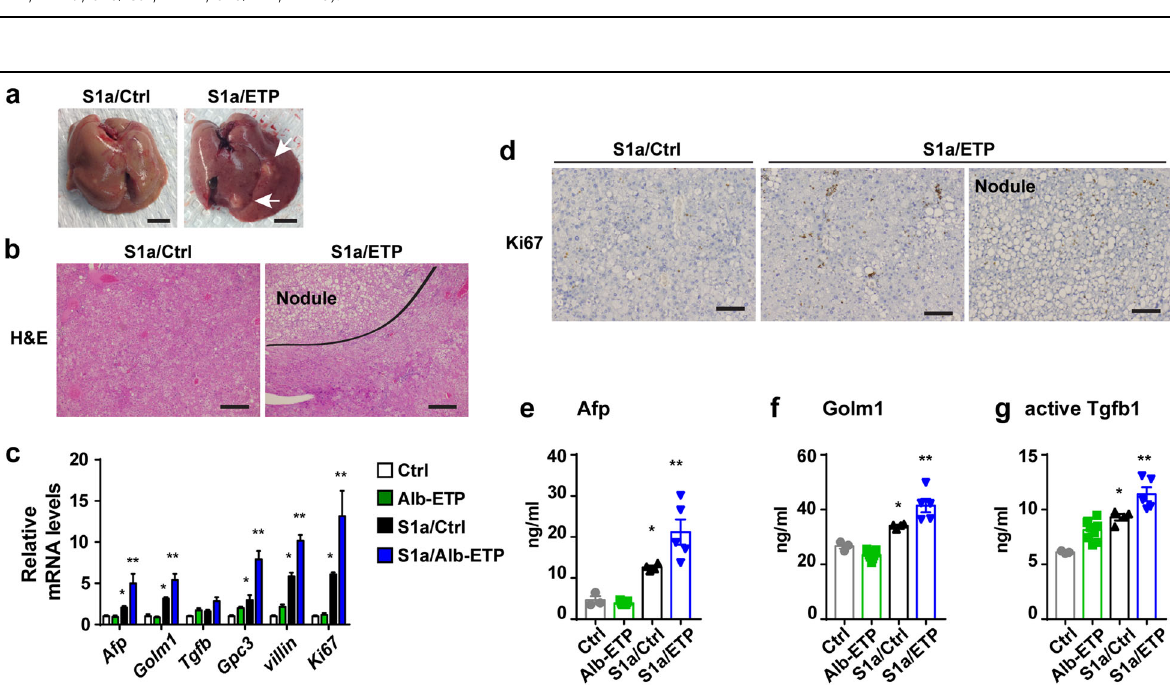
Fig. 3 Chronic exposure to endotrophin (ETP) induces liver cancer in the S1a/Ctrl transgenic mice. a Representative gross image of the ETP/ S1a mouse livers with nodules. Arrowheads indicate nodules and H&E staining of liver tissues; N, nodule. Bars: Gross images (75 mm). H&E staining: (375µm). b Liver cancer markers were determined by qPCR of liver tissues, and the results were normalized based on B2m expression. c Ki67 staining and d – f positive liver cancer markers, including serum alpha-fetoprotein, GP73, and active TGF levels, were measured. * p < 0.05 vs. the level of the Ctrl mice. ** p < 0.05 vs. the level of the S1a/Ctrl mice. Bars: 150 µm (Ctrl, n = 3; Alb-ETP, n = 9; S1a/Ctrl, n = 4; S1a/ETP, n =